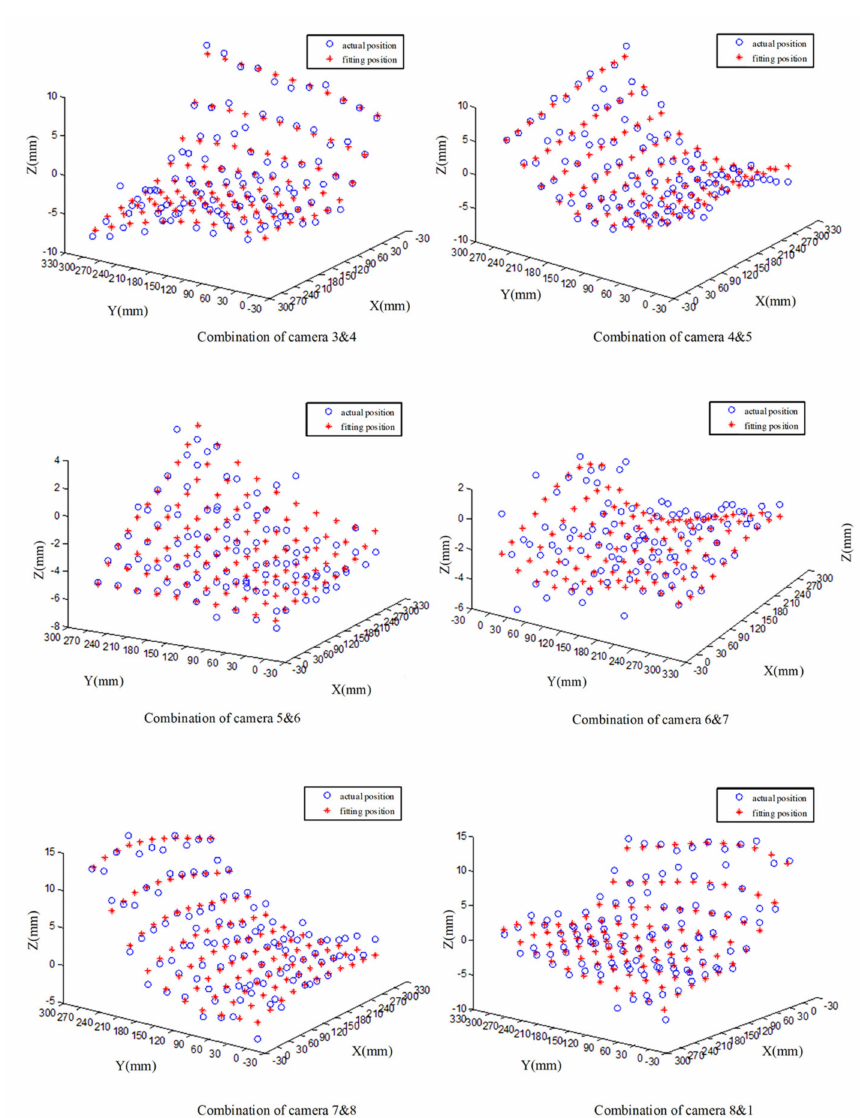
Figure 14. Results of fitting error of combinations of adjacent cameras in Z